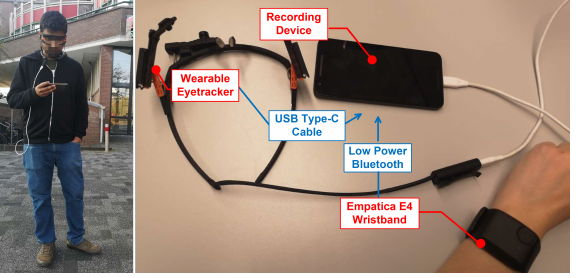
Figure 6. The hardware setup of MERCA. Image of study participant shown with permission. Table 1. Technical and physiological specifications of sensors used in CASE and MERCA